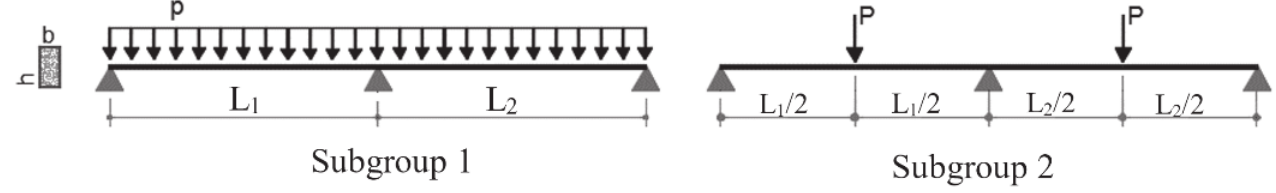
Loading patterns and variables used to define the geometry of two-span beams